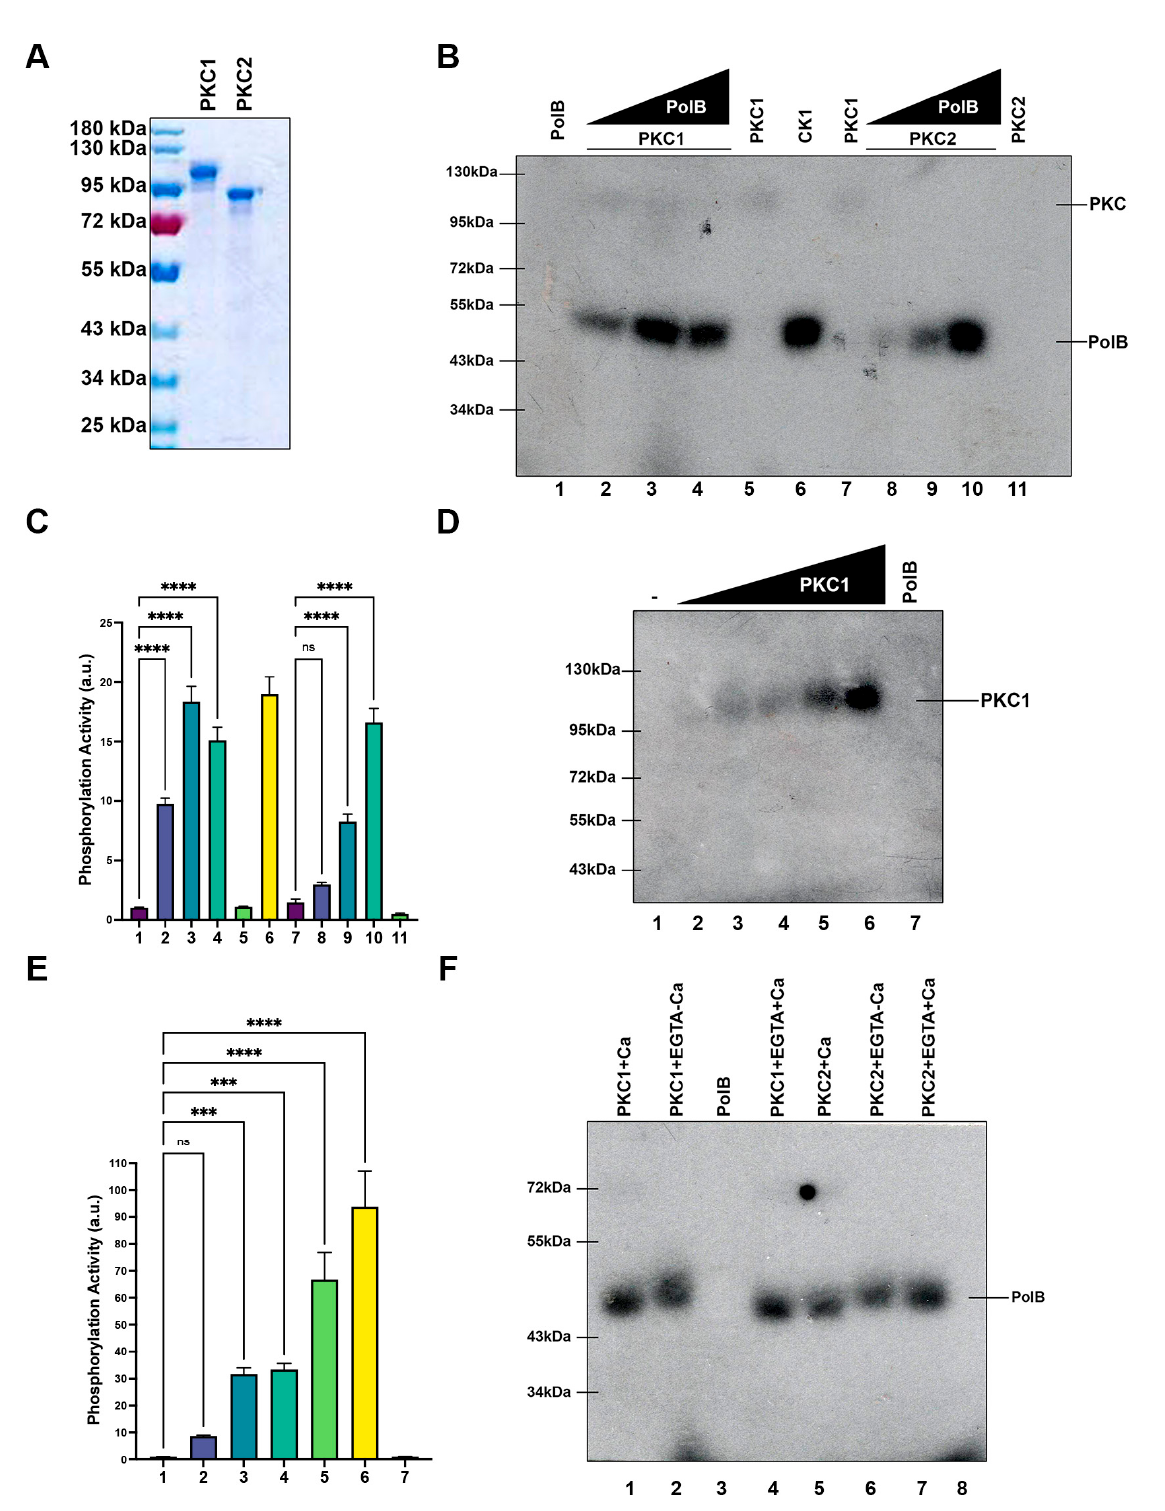
Figure 4. TcPKC1 and TcPKC2 can phosphorylate Tcpol β in vitro. The genes for both TcPKC1 and TcPKC2 were cloned, expressed and the proteins purified by NTA-Ni-Agarose column. ( A ) Two hundred (200 ng) of each purified protein were analyzed in a PAGE-SDS (7% gel) followed by Coomassie Blue R-250 staining. ( B ) Tcpol β phosphorylation by TcPKC1 and TcPKC2. Two (2 pmol) of each protein kinase were used to phosphorylate 1, 2 and 4 pmol of recombinant Tcpol β . In the figure can be seen that TcPKC1 is weakly auto phosphorylated (lanes labeled PKC1). The phos- phorylated Tcpol β (PolB) is shown in the figure. A positive control is shown using CK1 (lane la- beled CK1). Tcpol β by itself is not phosphorylated (lane labeled PolB). ( C ) Quantification of ( B ). ( D ) TcPKC1 is auto phosphorylated. Several amounts (2, 4, 8, 16 and 32 pmol) of TcPKC1 (PKC1) were incubated in the kinase reaction buffer. Tcpol β alone (PolB) was used as a negative control. ( E ) Quantification of ( D ). ( F ) TcPKC1 and TcPKC2 do not require calcium for activity. Four (4 pmol)